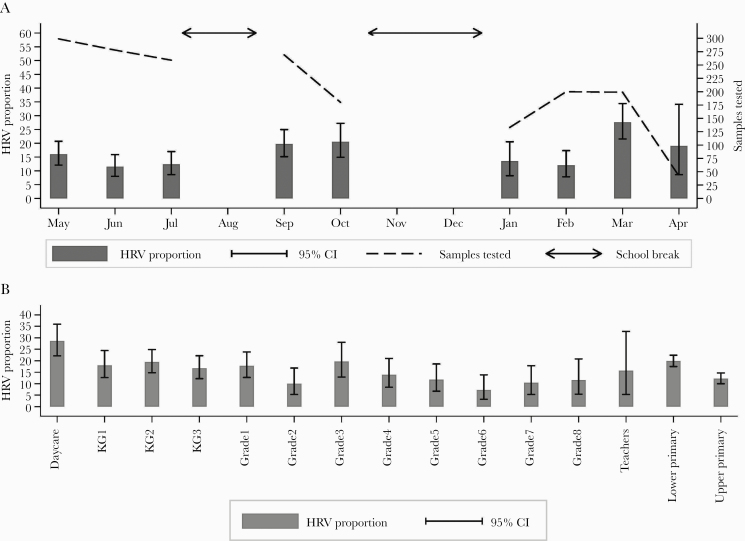
Patterns of HRV infections within the school over 1 year. A, Month-by-month HRV proportion with respective 95% confidence intervals and number of samples tested. B, Class-specific HRV proportion with respective 95% confidence intervals. The 2 bars furthest to the right are aggregated proportions of lower primary and upper primary groups. Abbreviation: HRV, human rhinovirus.